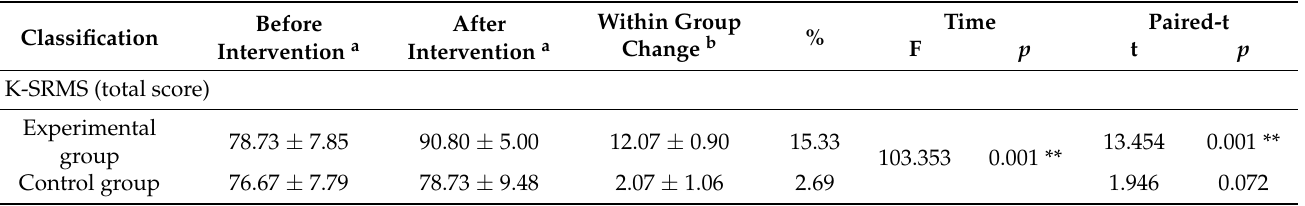
Table 7. Changes in rehabilitation motivation before and after intervention on two intervention